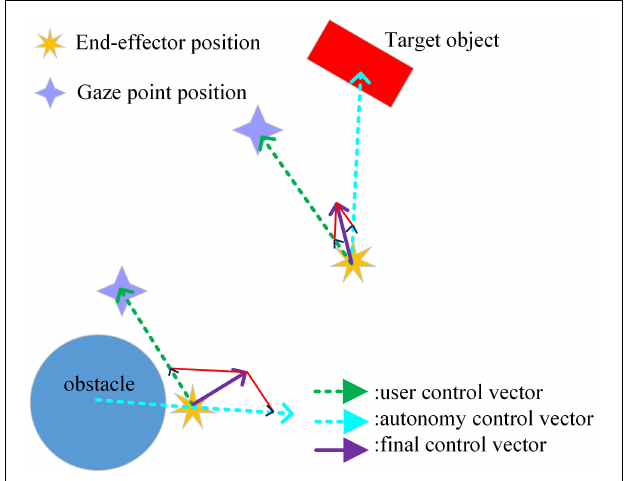
FIGURE 6 | The principle for the shared control in direction.